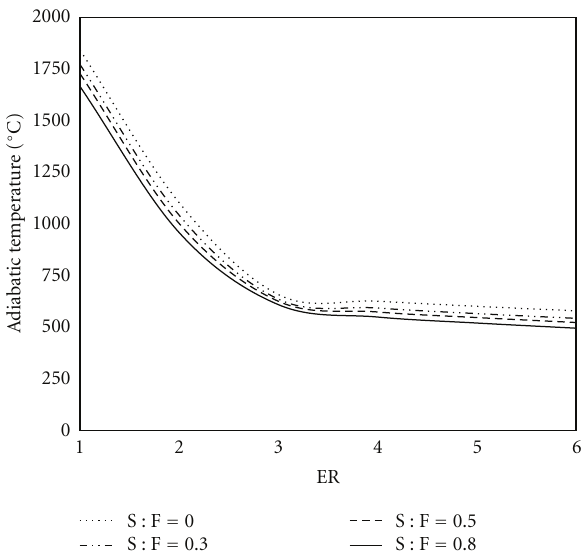
Figure 2: Adiabatic temperature estimated with equilibrium model for various S:F ratios, adopted from [14].